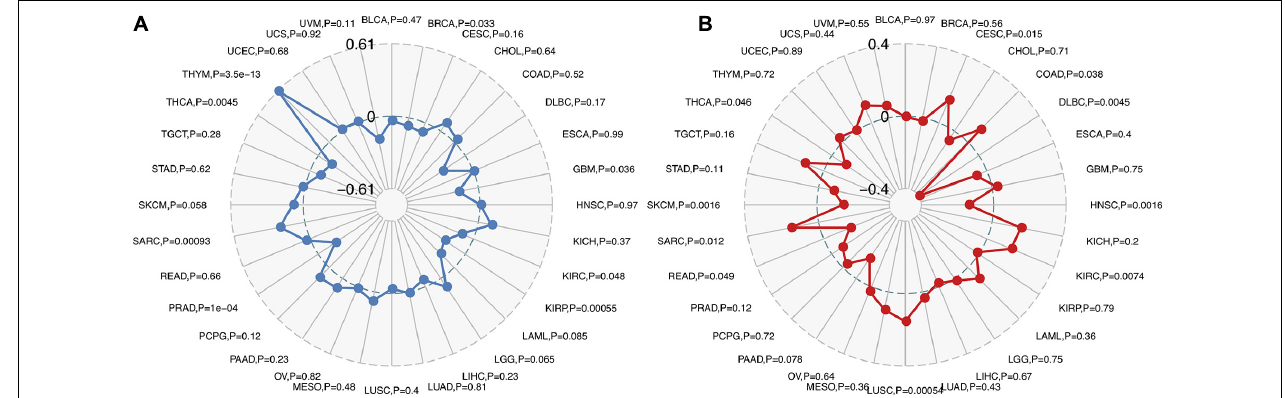
FIGURE 4 | Correlations of FURIN expression with TMB and MSI across cancers. (A) The correlation of FURIN expression with TMB across cancers was illustrated by the radar chart. The value in black reveals the range and the curve in blue reveals the correlation coefficient. (B) The correlation between FURIN expression and MSI across cancers was illustrated by the radar chart. The value in black reveals the range and the curve in red reveals the correlation